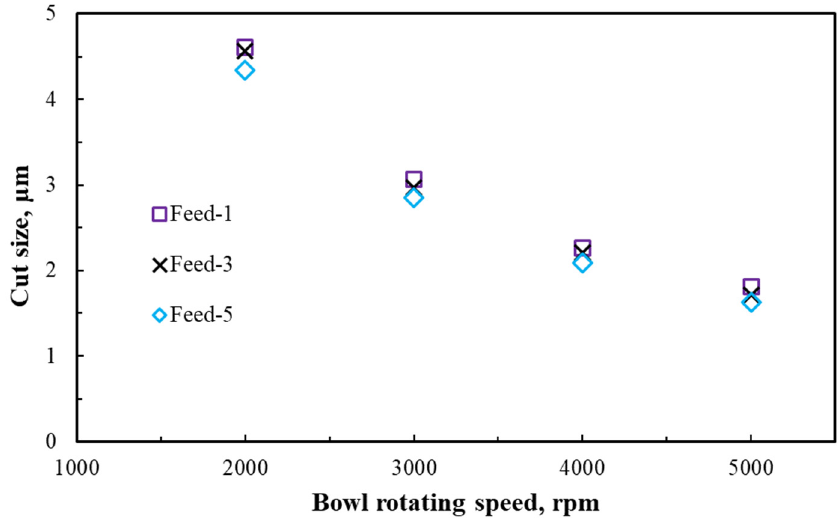
Figure 4. The relationship between the bowl rotating speed and cut size, with different feeds.